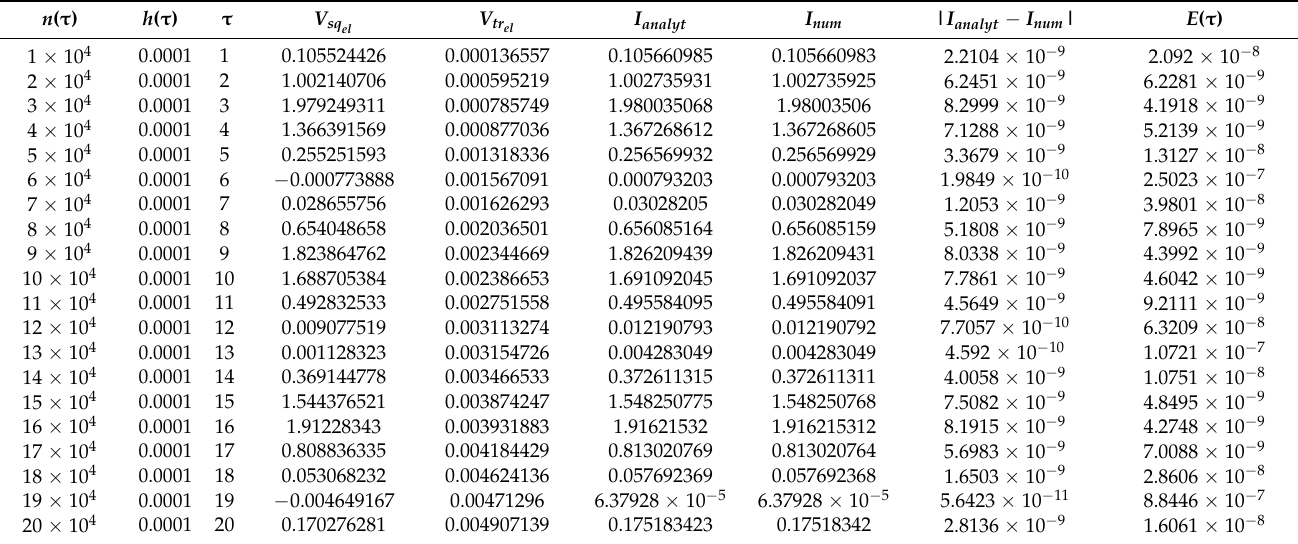
Table 10. Calculation of integral